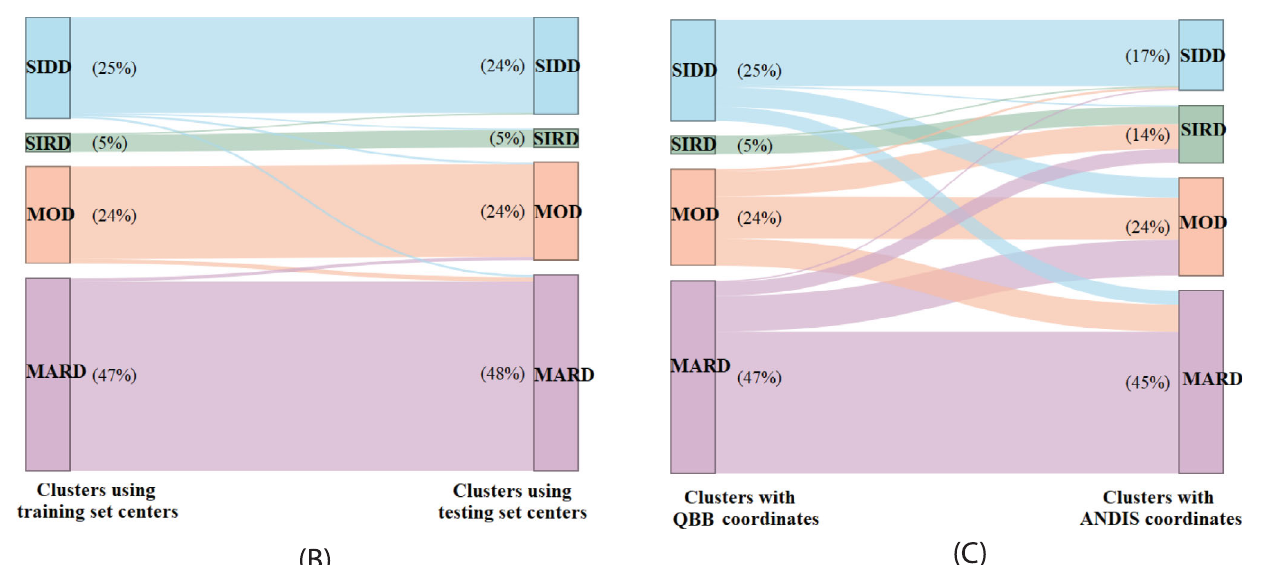
Fig.2|ClustercharacteristicsandclusterdistributioninQBB. K-meansclusters werederivedusingtheQBBtrainingsetandclassi fi cationwasappliedtothetesting set using the training set cluster coordinates. A Distributions of HbA 1c , BMI, age, HOMA2-B, and HOMA2-IR are shown for each cluster in QBB ( N =420 individuals) and ANDIS ( N =8980 individuals). HbA 1c , BMI, HOMA2-B, and HOMA2-IR all fol- lowed the same trend in QBB and ANDIS, but individuals in the MOD cluster were younger than the other clusters in QBB. Data in boxplots are presented as follows: lower and upper whiskers represent the minima and maxima respectively, box centers represent the median values, bounds of boxes represent the fi rst and third quartiles, notches represent the 95%con fi denceintervalof the median,and circles representoutliers. B Thetestingsetclustersweresimilartothetrainingsetclusters, regardless of whether they were assigned based on the training set coordinate centers or derived de novo for the testing set using K-means clustering. Minor